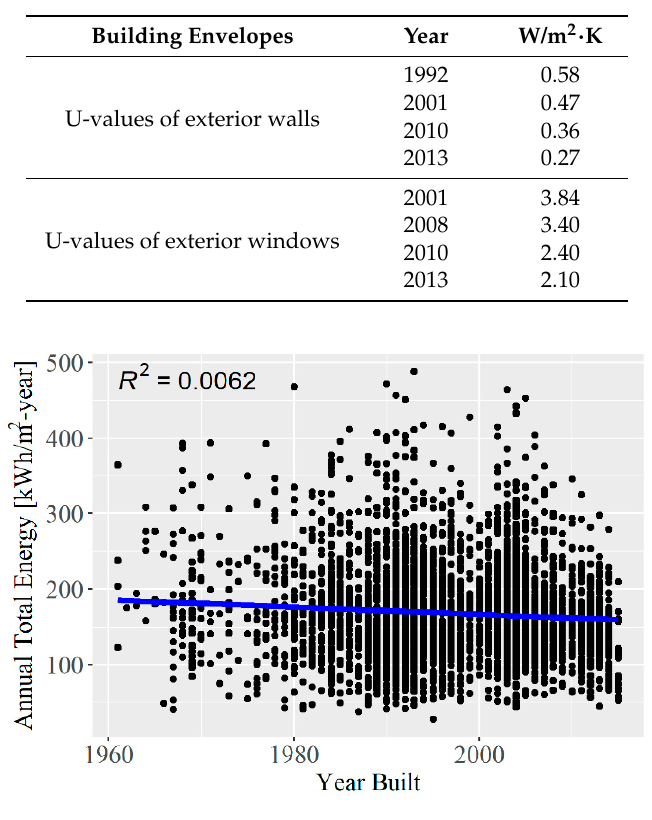
Figure 4. Relationship between year built versus annual total energy consumption of 4,625 office buildings in Seoul, Korea. (The ggplot2 package on R was used).